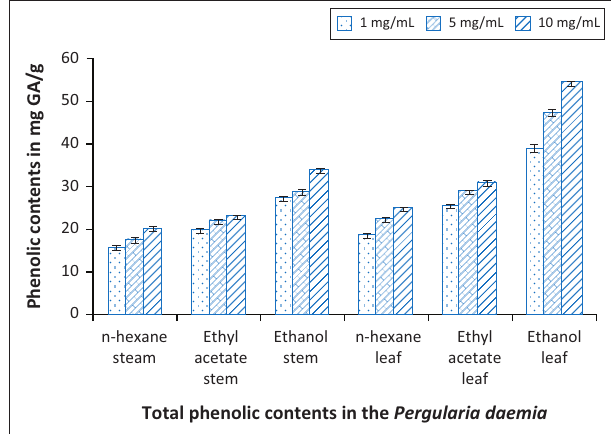
FIGURE 1: Estimated phenolic contents in the stem and leaf extracts of Pergularia daemia at 1 mg/mL, 5 mg/mL and 10 mg/mL of each extract.